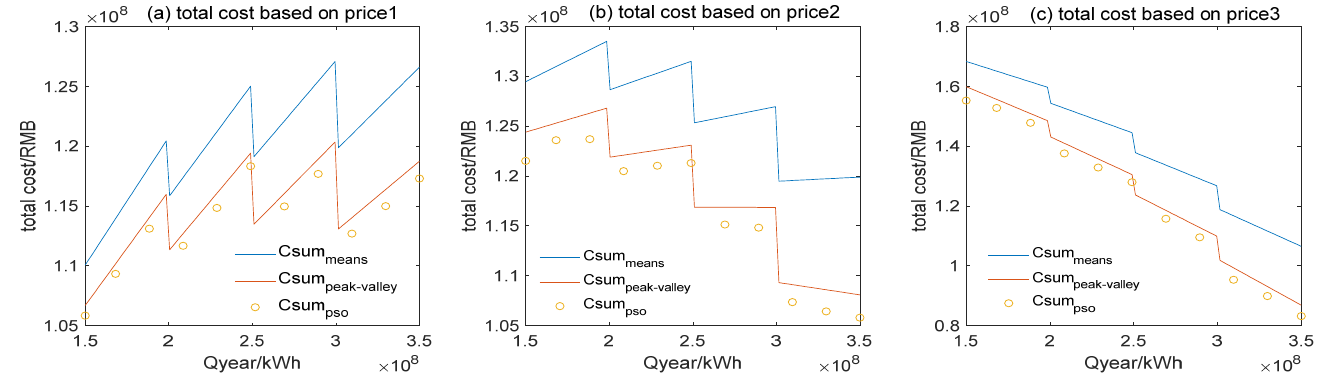
Figure 23. The influence on the total electricity cost with different medium- and long-term